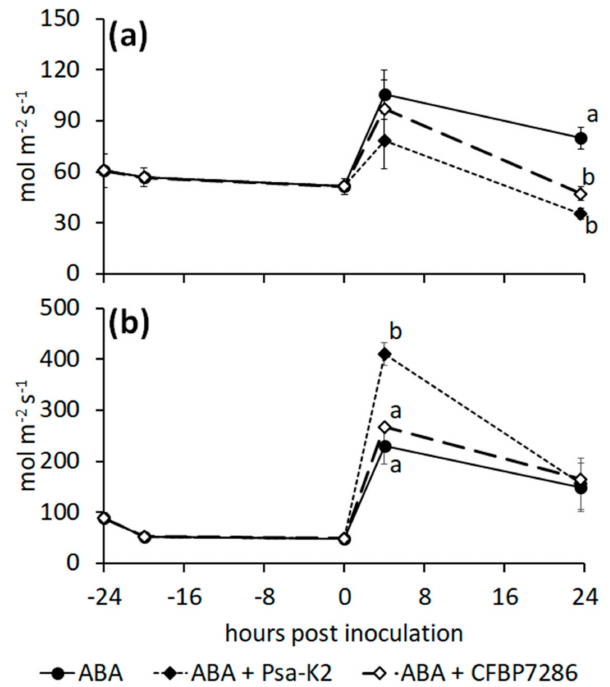
Figure 7. Interaction of Pseudomonas syringae pv. actinidiae with ABA on stomata. ( a ) Stomatal conductance of Actinidia deliciosa or ( b ) A. chinensis plants treated with ABA 1 day before inoculation with Pseudomonas syringae pv. actinidiae strains CFBP7286 or Psa-K2. For each time point, significant differences (determined by ANOVA followed by Fisher’s least significant difference test with p ≤ 0.05, n = 4) are indicated by different